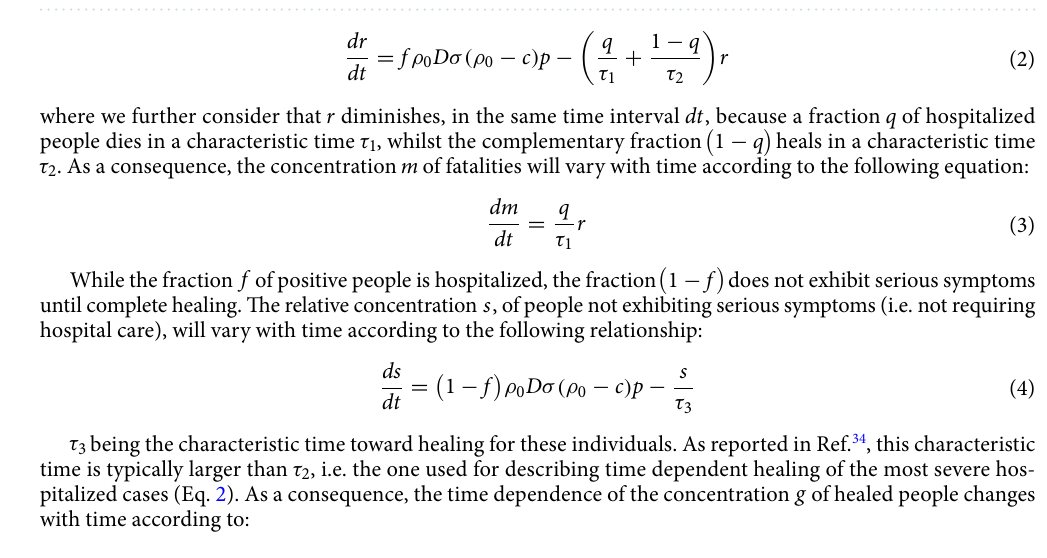
Figure 1. Experimental data of hospitalized people (open circles), fatalities (open squares), people tested positive for the viral infection (open triangles), since the beginning of the Covid-19 outbreak in Italy ( a ), in Lombardia ( b ), in Sicily ( c ), and in Lazio ( d ),